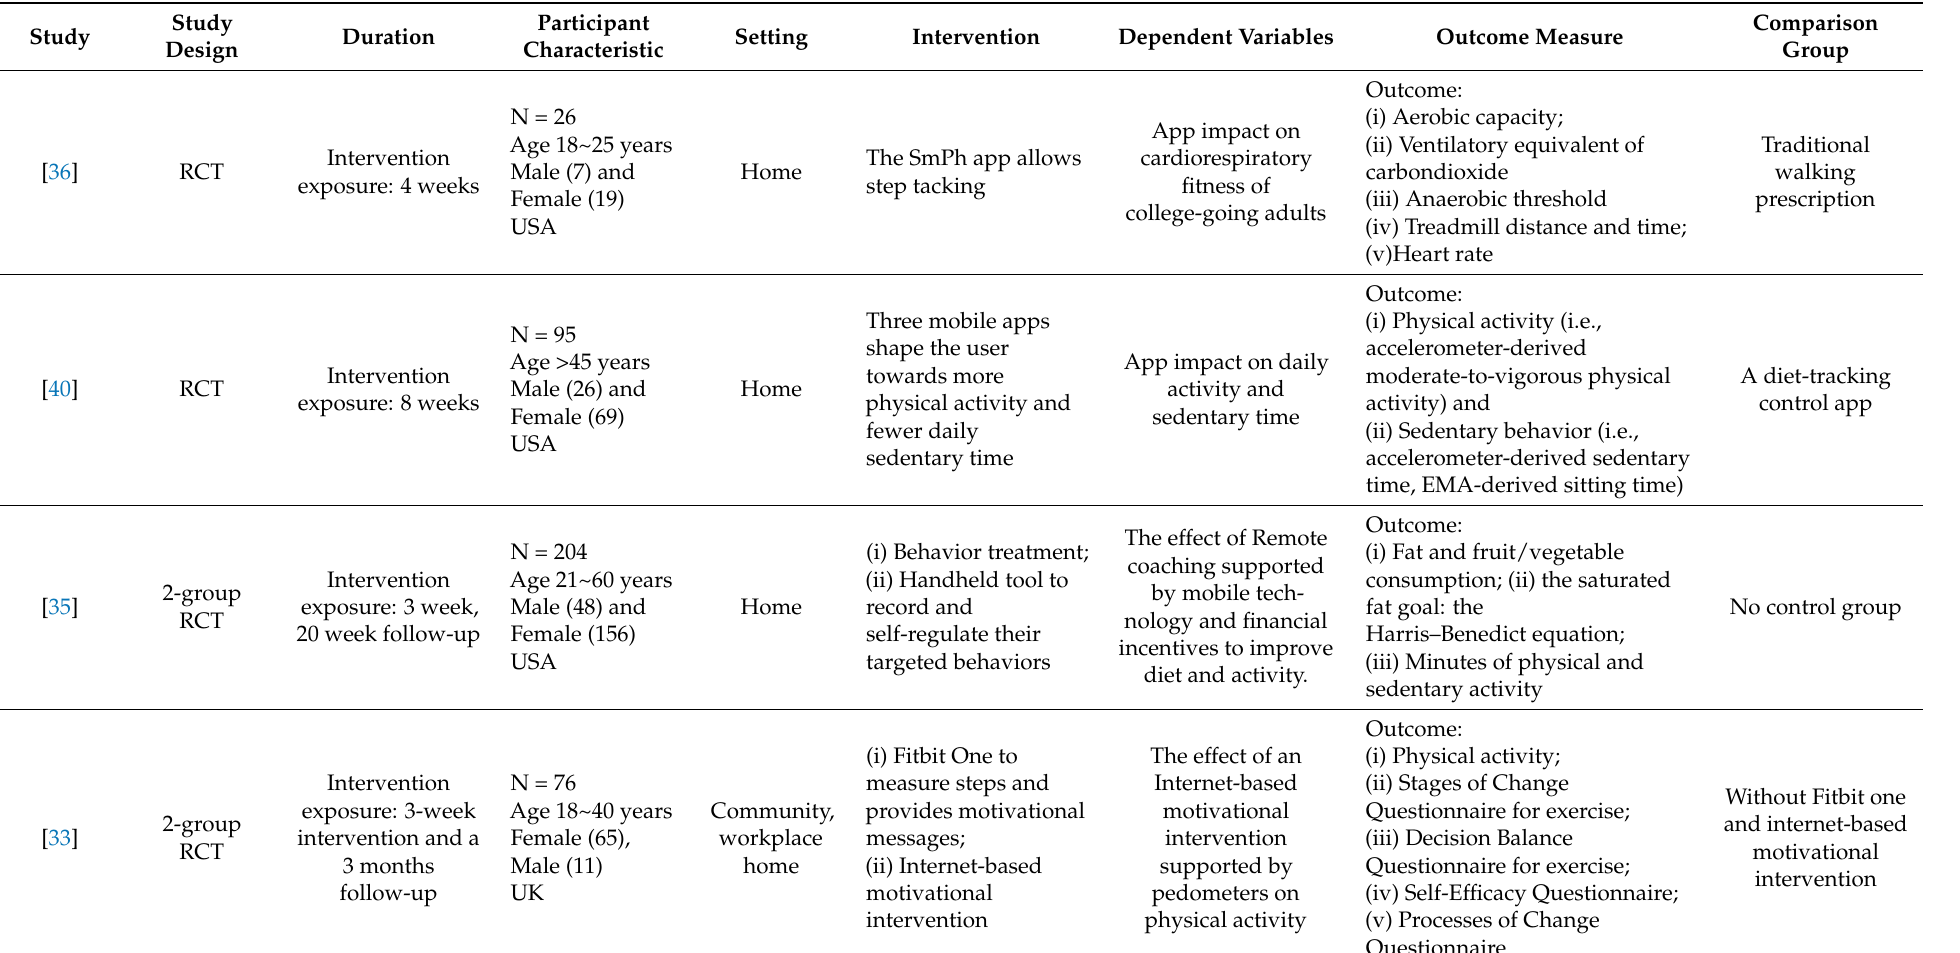
Table A1. Synthesis of main variables collected from RCTs ( n =